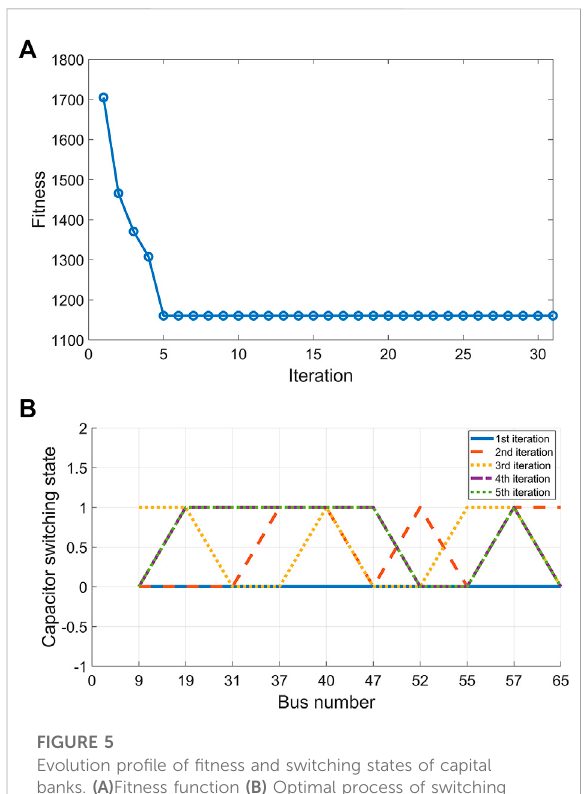
FIGURE 5 Evolution pro fi le of fi tness and switching states of capital banks. (A) Fitness function (B) Optimal process of switching capacitor banks at each node.